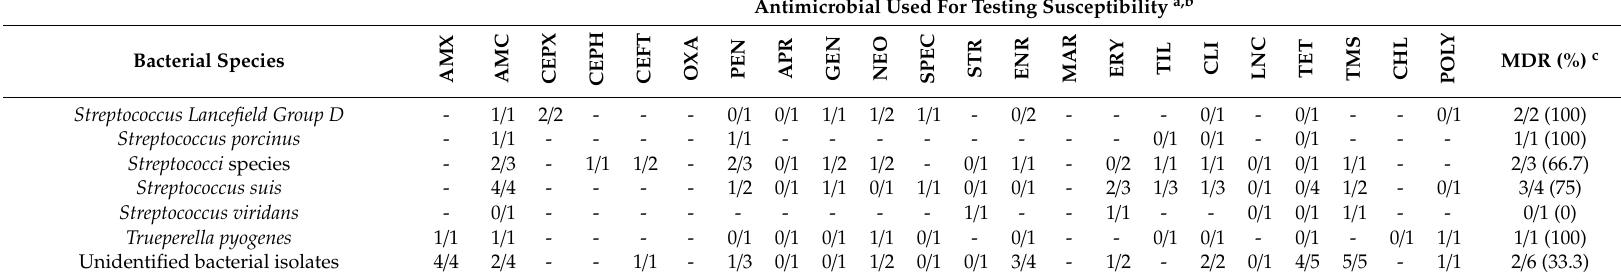
Table 3. Cont. Antimicrobial Used For Testing Susceptibility